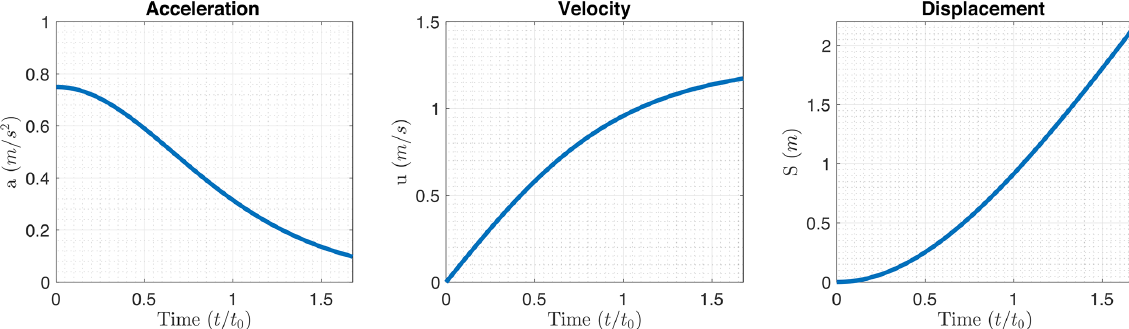
Figure 4. BP1. Prescribed acceleration, velocity, and displacement of the solid slide.